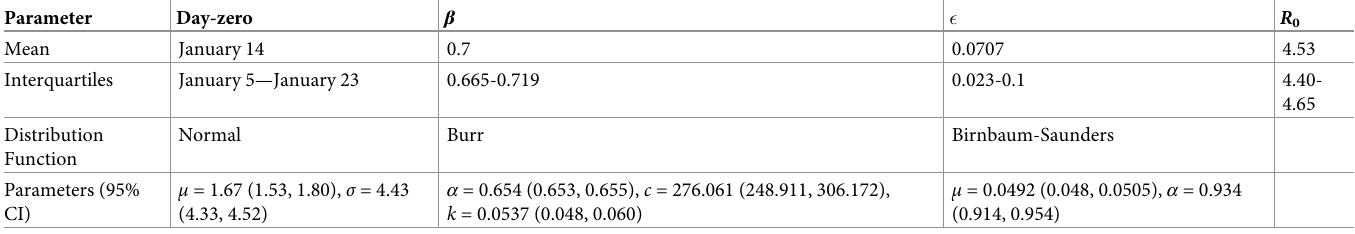
Table 1. Optimal parameter values and interquartiles for day-zero, transmission rate ( β ) and fraction ( � ) of the cases of exposed individuals in the total population that enter to the compartment I c . The resulting value of R 0 along with the minimum and maximum value is also